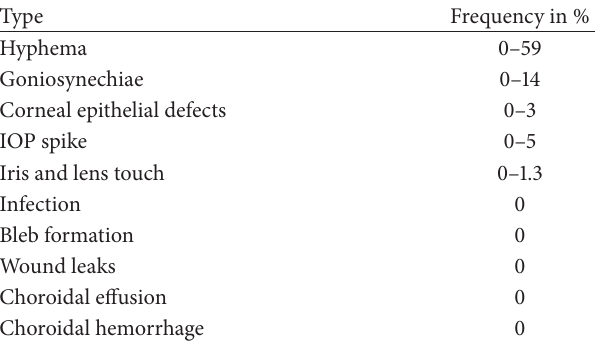
Table 2: Frequency of reported Trabectome complications.